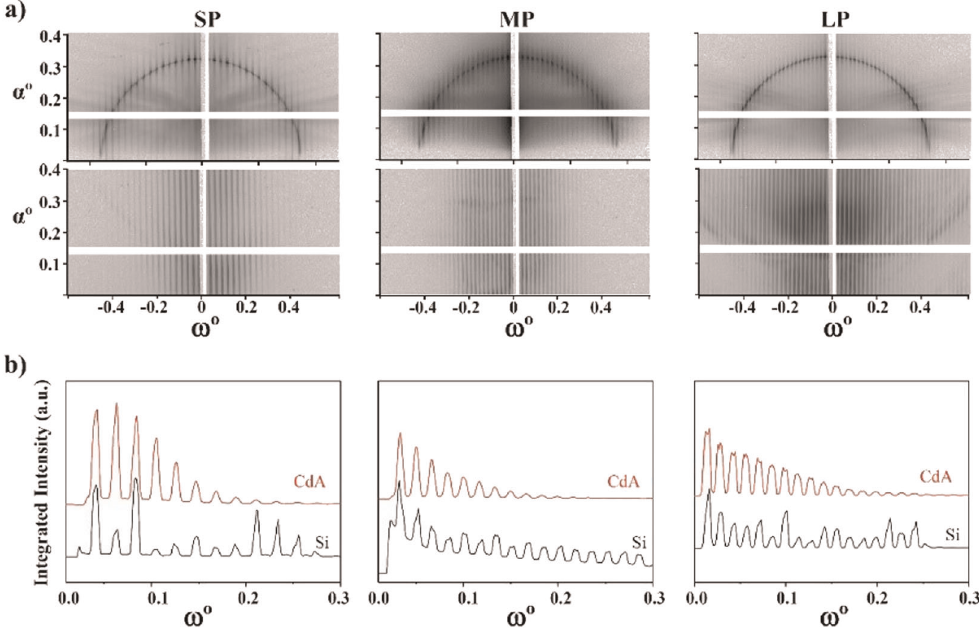
Fig. 4 a 2D GISAXS patterns corresponding to the Si gratings (top row) and to the replica prepared by NIL in CdA foil (bottom row). b 1D integrated X-ray intensity for the Si molds (black) and CdA replica (red) obtained by integrating the intensity along the vertical direction of the GISAXS. In order to facilitate the comparison between the periods of the Si mold and the CdA copy only one half of the curve is presented